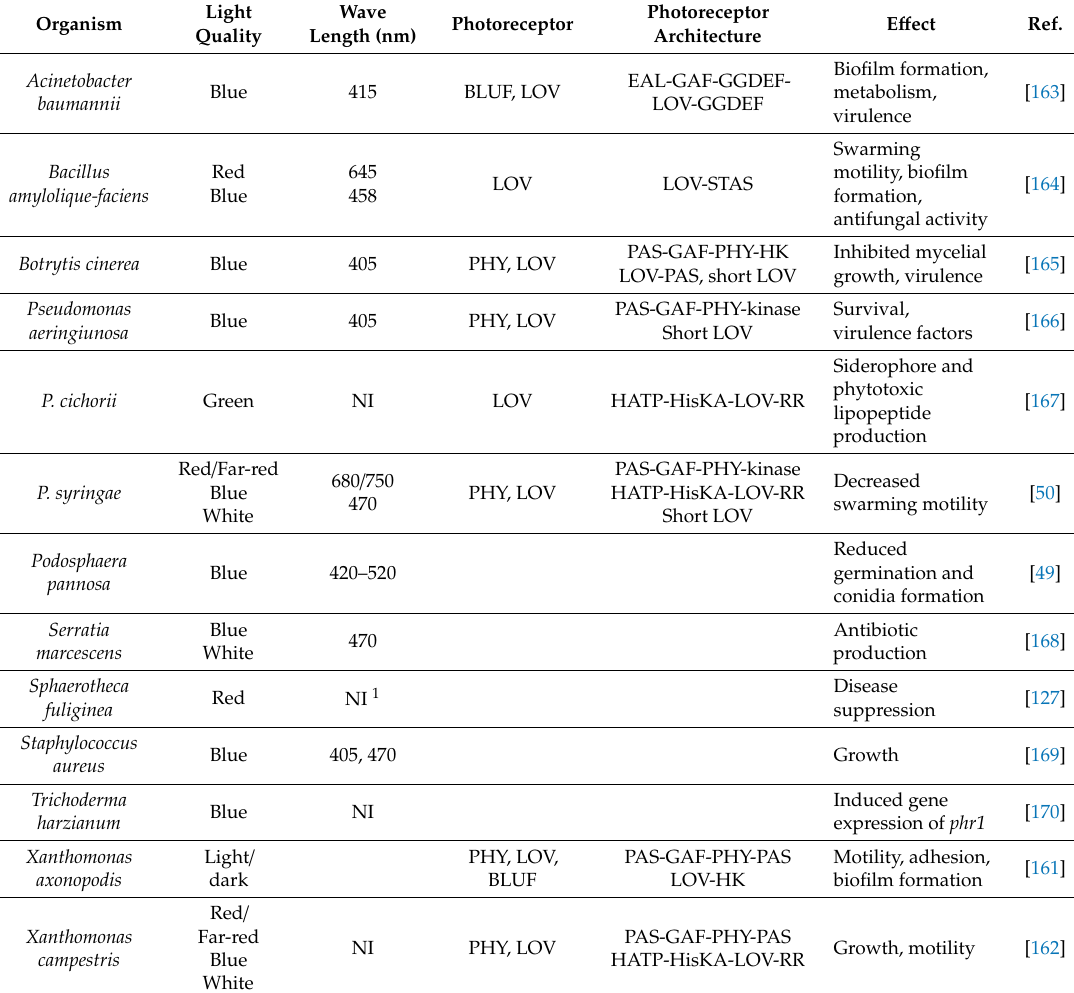
Table 2. Summary of di ff erent microorganisms, the photoreceptor / s they contain, and the physiological response to di ff erent light